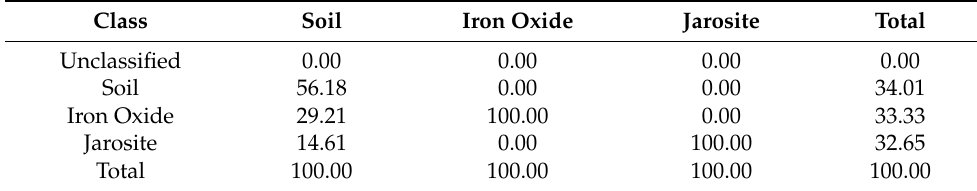
Table A10. September 2018 spectral angle mapper. Overall accuracy points: 108/147, overall accuracy: 73%, kappa coefficient: 0.6005.